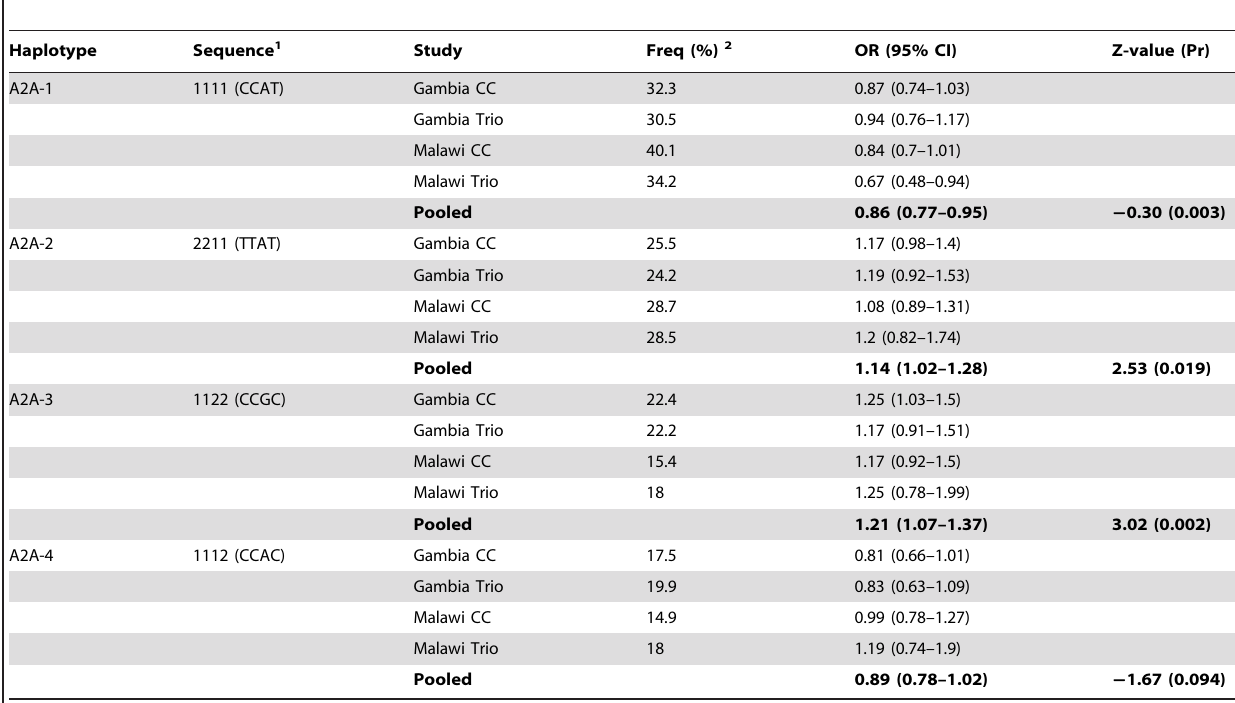
Table 3. Pooled haplotype-based odds ratios of association with severe malaria in the ADORA2A gene.